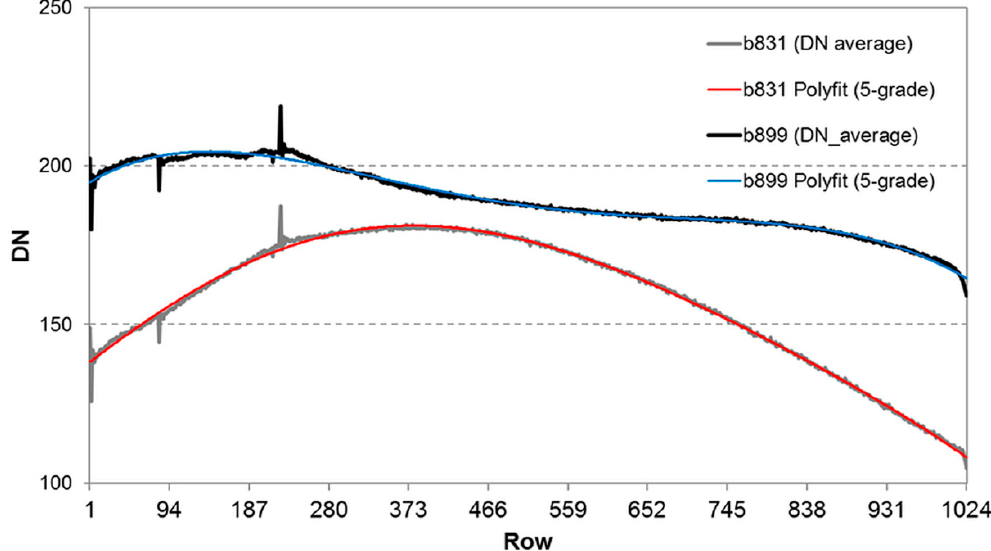
Figure 6. Row-wise average and 5-grade approximation of band-noise affected flat-field images of b 891 and b 899 .